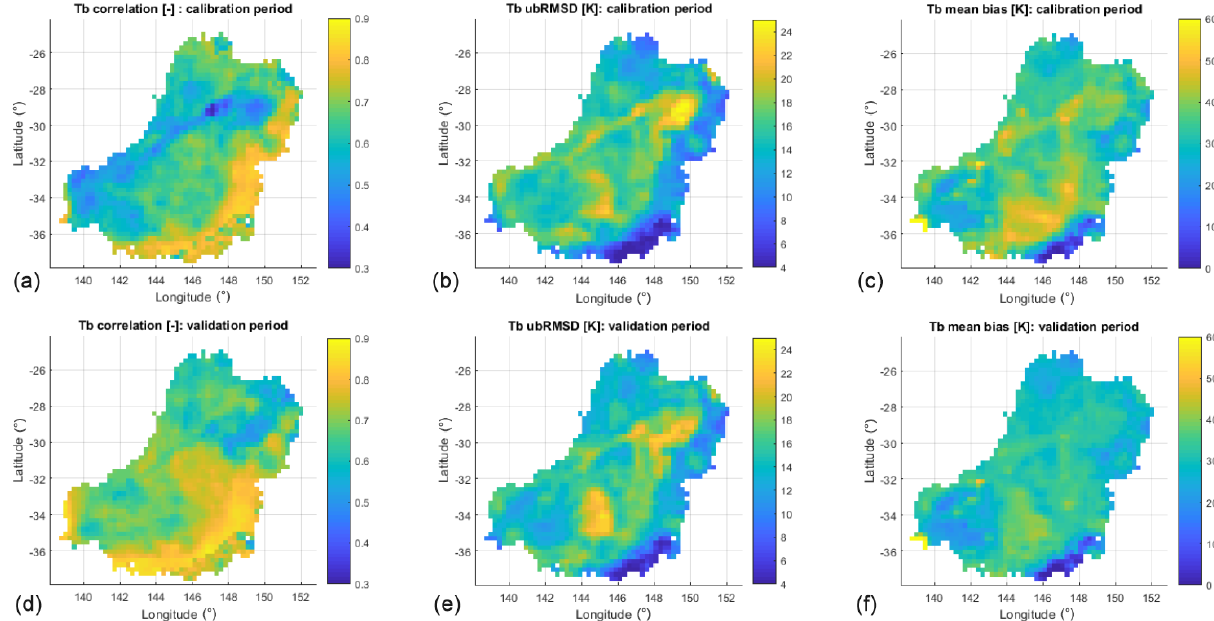
Figure 3. Performance and error metrics of SFX-simulated Tb using, as a reference, SMOS Tb. ρ coefficients (a, d) , unbiased root mean square deviations (ubRMSD; b , e ) and mean biases (c, f) between SFX–CMEM predictions and SMOS observations of Tb during the calibration (a–c) and the validation (d–f)